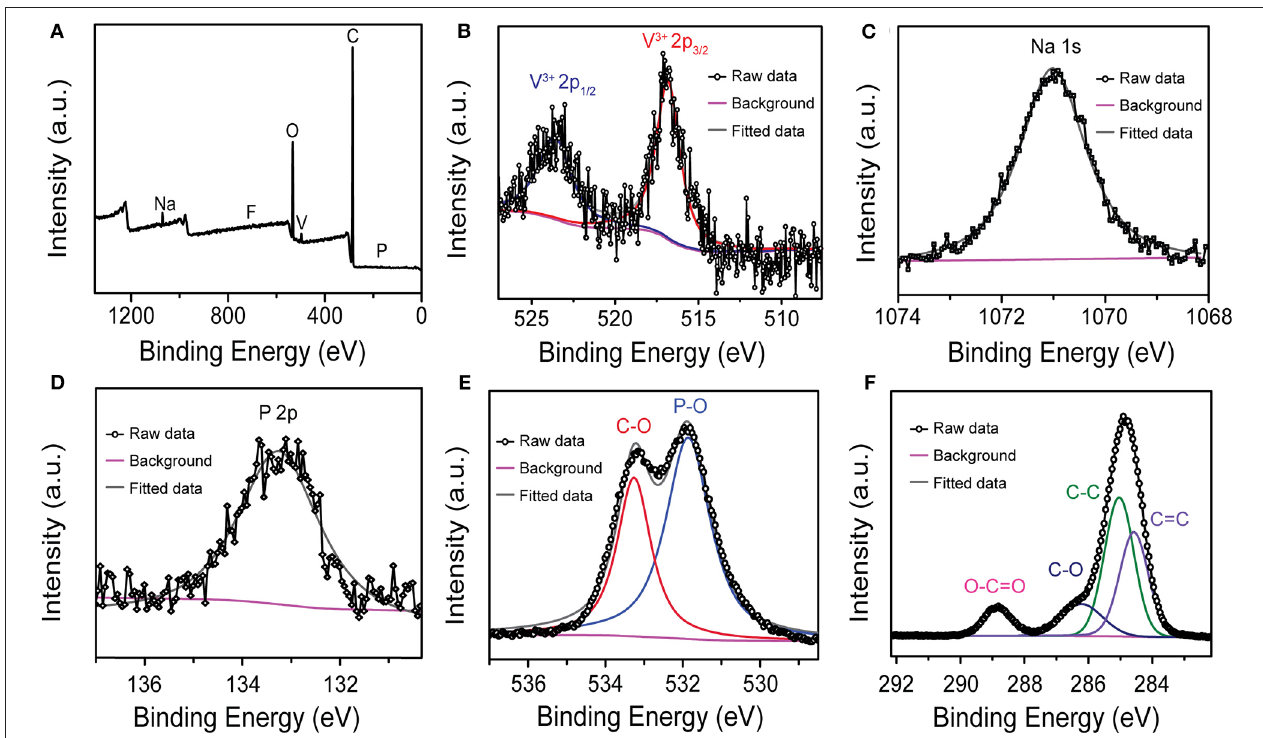
FIGURE 2 | (A) Full XPS spectra of the NVPF/C/rGO; high-resolution (B) V 2p, (C) Na 1s, (D) P 2p, (E) O 1s, and (F) C 1s spectrum of the NVPF/C/rGO.